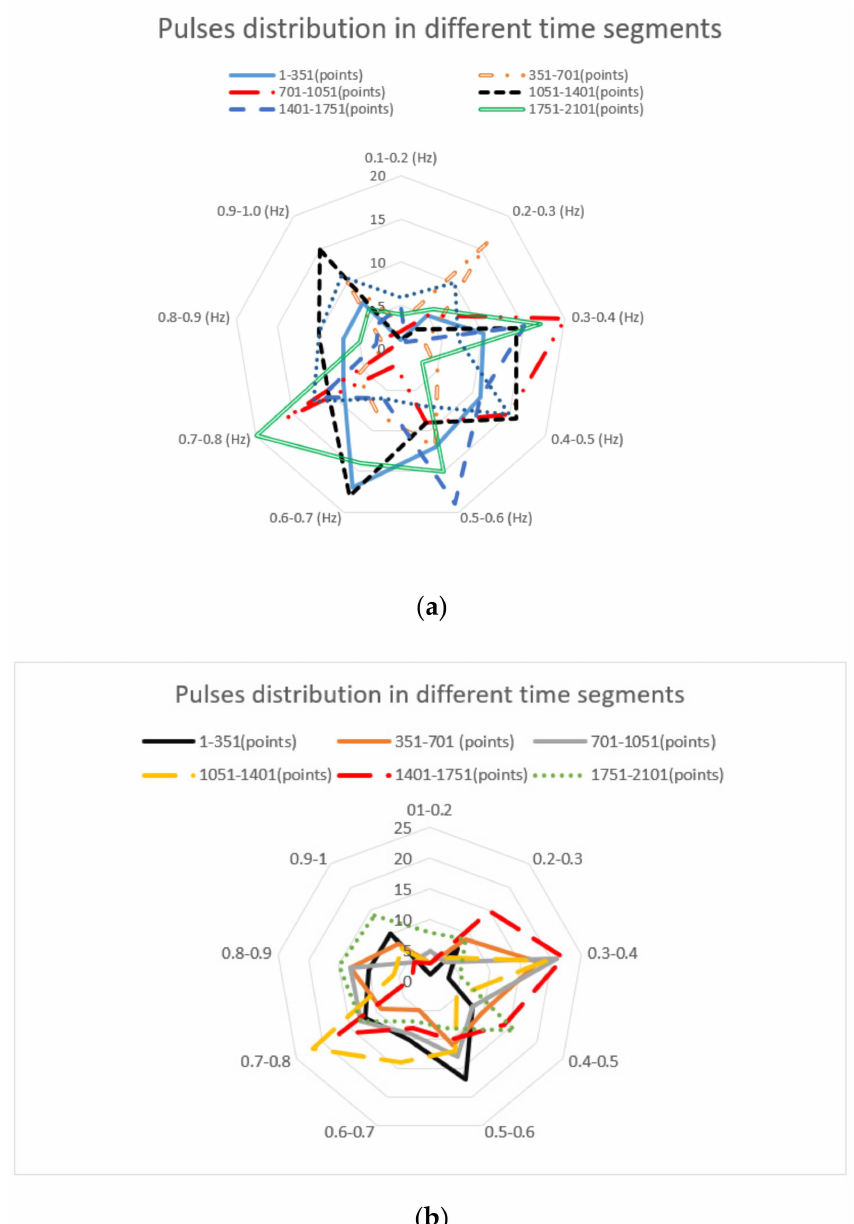
Figure 8. Pulse distribution in different time segments of two data sets: ( a ) pulse distribution of frequency ranges in different time segments (Abnormal data set), ( b ) pulse distribution of frequency ranges in different time segments (Normal data